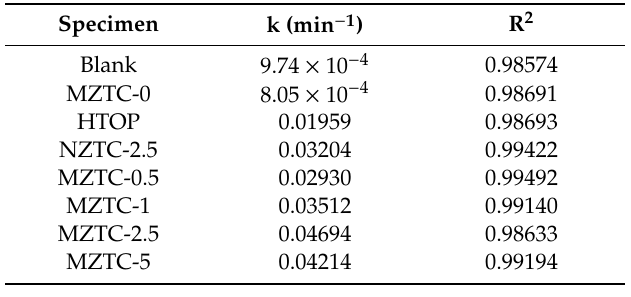
R 2 = goodness of fit).